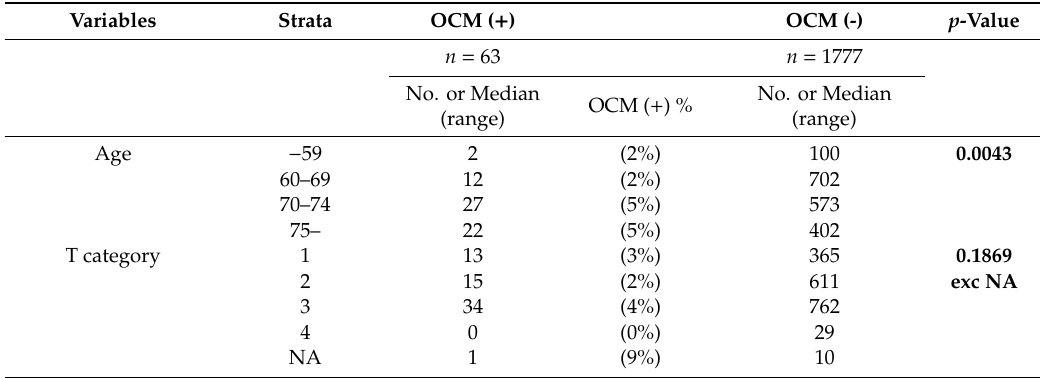
Table 2. Characteristics and treatment factors for